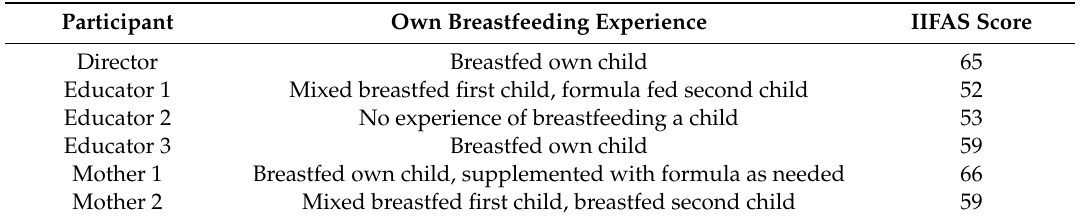
Table 1. Participant